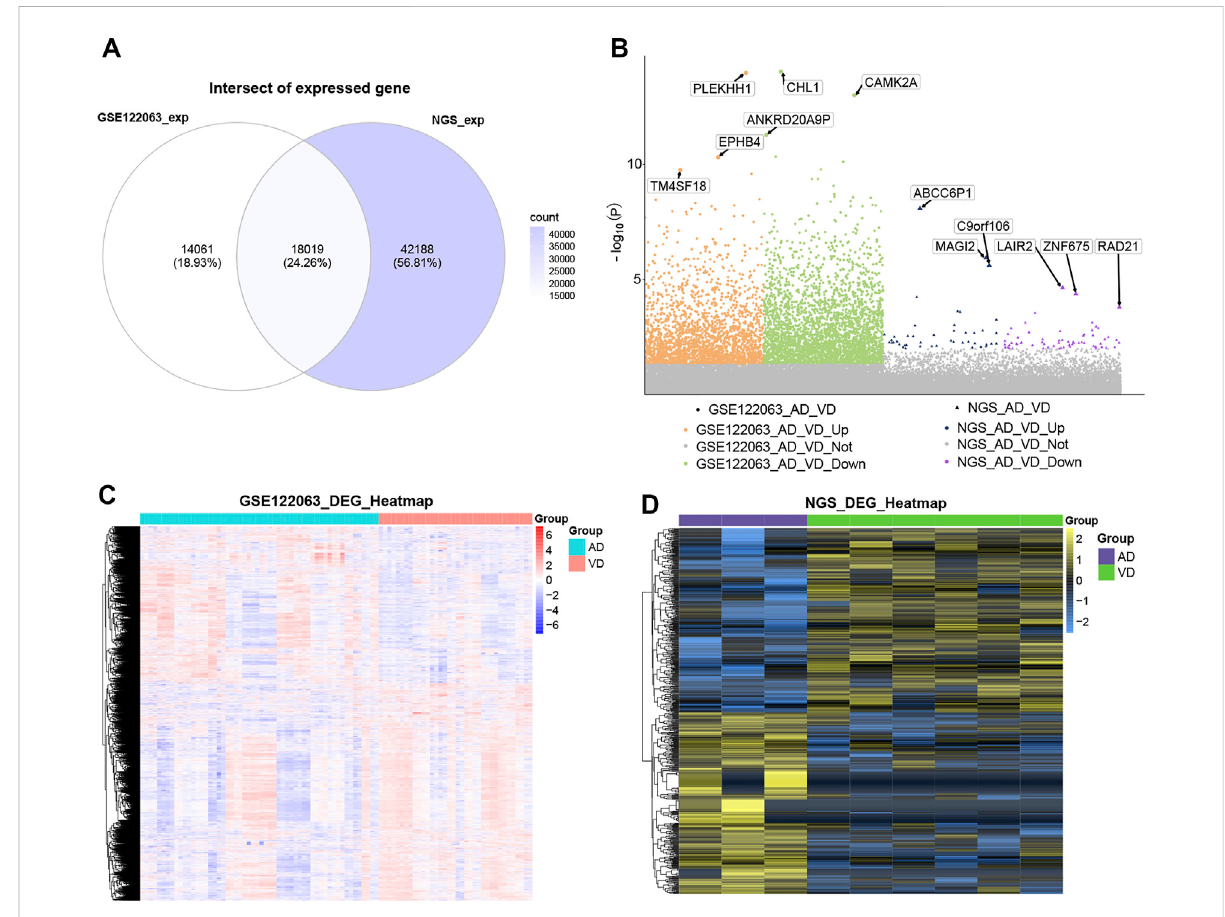
FIGURE 2 Differential expression analysis. (A) The venn diagram showed the genes overlaped in the blood expression pro fi le of GSE122063 data set and sequencing data. (B) Manhattan map of differential gene expression. (C) The heat map of DEGs in GSE122063 data set. (D) The heat map of DEGs in Next Generation Sequencing data (NGS). AD, Alzheimer ’ s disease; VD, vascular